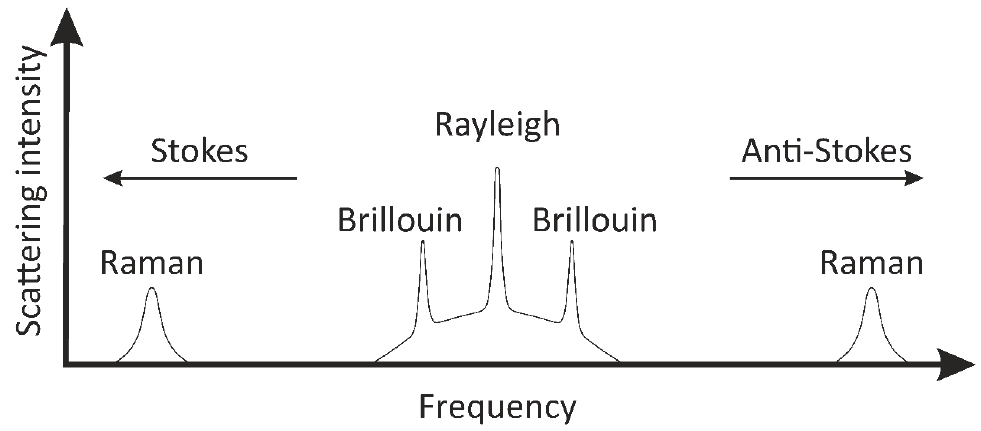
Figure 1. Typical spontaneous light scattering spectrum.